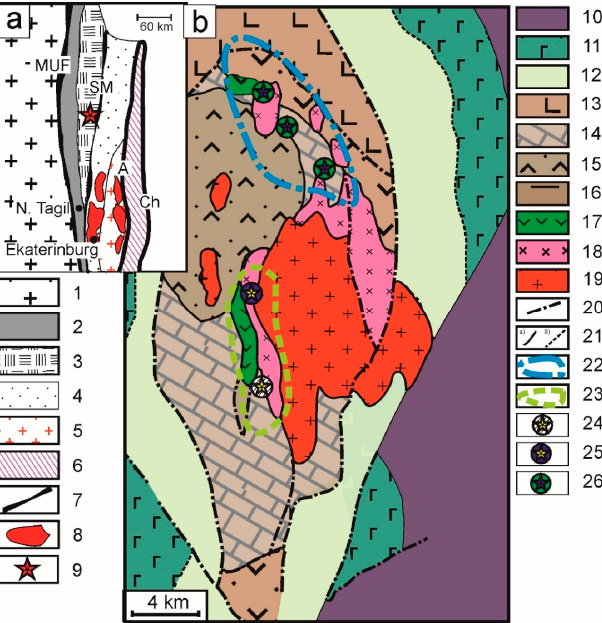
Figure 1. The position of the Auerbakh intrusion in the structures of the Urals (a) and geological scheme of the structure of the Turyinsk-Auerbakh metallogenic province (b). ( a ): 1—the passive margin of the western slope of the Urals; 2—the platinum belt of Tagil megazone; 3—Tagil vol- canic zone; the zones of the active continental margin: 4—Devonian-Carboniferous; 5—continen- tal; 6—northern; 7—tectonic sutures separating large structures of the Urals: the Main Uralian Fault (MUF), Serovsko-Mauksky (SM), Alapaevsky (A), Chelyabinsky (Ch). Plutonic massifs: 8— granite; 9—Auerbakh gabbro-diorite-granite (after [13]). ( b ): 10—Ordovician rocks of ophiolitic association; 11—basalt-rhyolite-plagiogranite association, Ordovician; 12—Silurian trachybasalt- trachyte; Devonian formations: 13—volcanic-sedimentary rocks with intercalations of andesites, andesite-basalts and limestones; 14—reef limestone; 15—volcanomictic rocks with tuff horizons of andesites and andesidacites; 16—andesibasalts; 17—extrusive andesites. Igneous rocks of the Au- erbakh Intrusion: 18—porphyritic diorites and gabbro-diorites; 19—quartz diorites, granodiorites and granites; other designations: 20—faults; 21—rock contacts: a) sharp; b) gradual; 22—Tur- yinskaya ore-magmatic system; 23—Vorontsovsko-Peshchanskaya ore-magmatic system; Depos- its: 24—Vorontsovskoe gold ore deposit; 25—Peshchanskoe iron ore deposit; 26—copper-skarn deposit (after [1]). The Vorontsovsko-Peshchanskaya hydrothermal system is located at the southwest- ern outer contact of the Auerbakh intrusion [1]. The Vorontsovskoe deposit is located in the southern part of this system, at a distance of 400–500 m from the southwestern exo- contact of the Auerbakh massif (Figure 1b) [7]. The volcanic-sedimentary rocks hosting the deposit form a monocline that gently dips to the west [6]. The sedimentary sequence includes limestones andlayers of tuffites and siltstones with a thickness of approximately 1 km. Usually, the limestone is metamorphosed to marbles. This sequence is conformably overlain subsequently by volcanic-sedimentary and volcanic rocks, such as tuffaceous silt- stone, tuffite and tuff. Coarse clastic breccias with tuffaceous cement are common at the